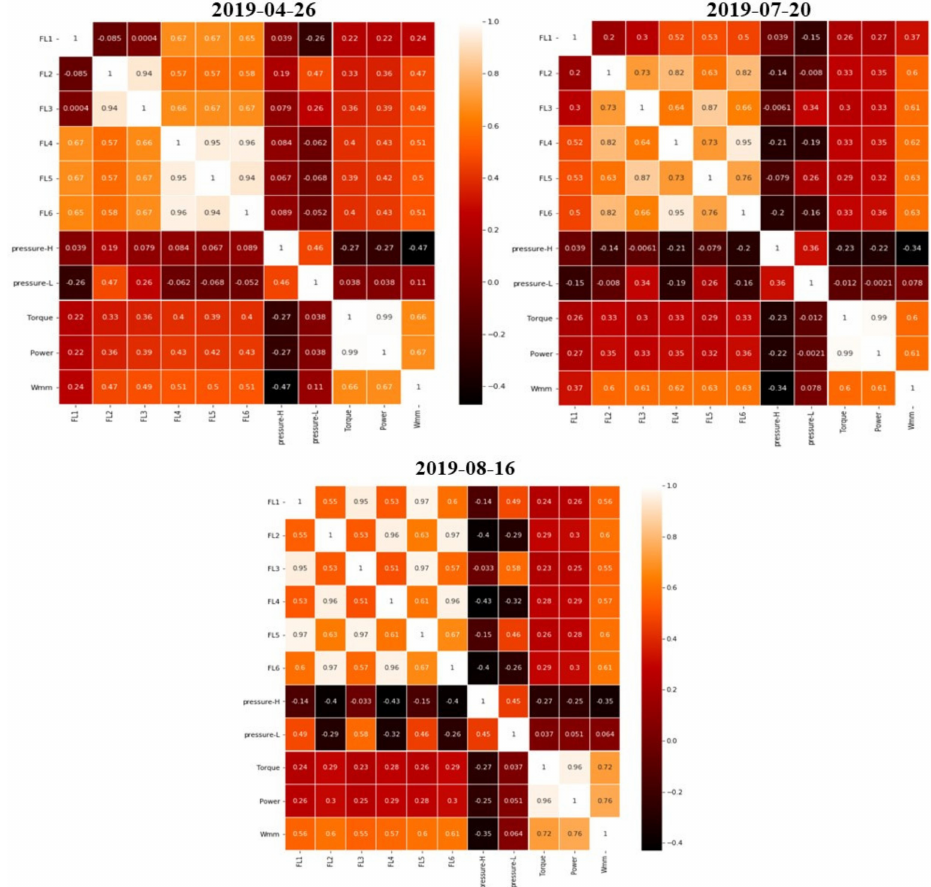
Figure 10. Correlation plots for the training